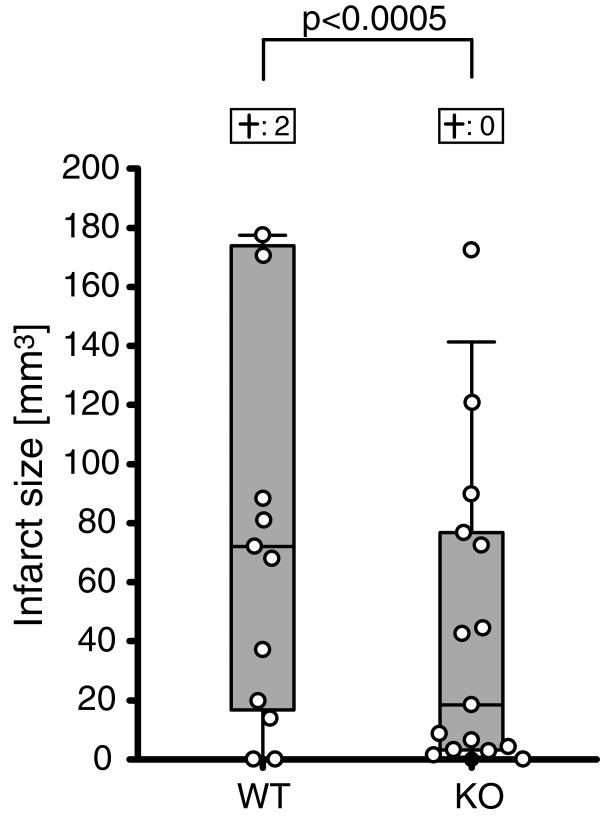
Infarct sizes were decreased in FLAP knockout mice. In terms of mortality-adjusted median infarct size, the knockout animals were protected from focal cerebral ischemia in comparison to their wild type counterparts (p < 0.0005). Infarct size is presented in mm3. The segments of the box plots depict the 10th, 25th, 50th, 75th and 90th percentile. The boxes above the box plots represent the mortality in the two groups. WT = Wild type group, KO = FLAP knockout group.